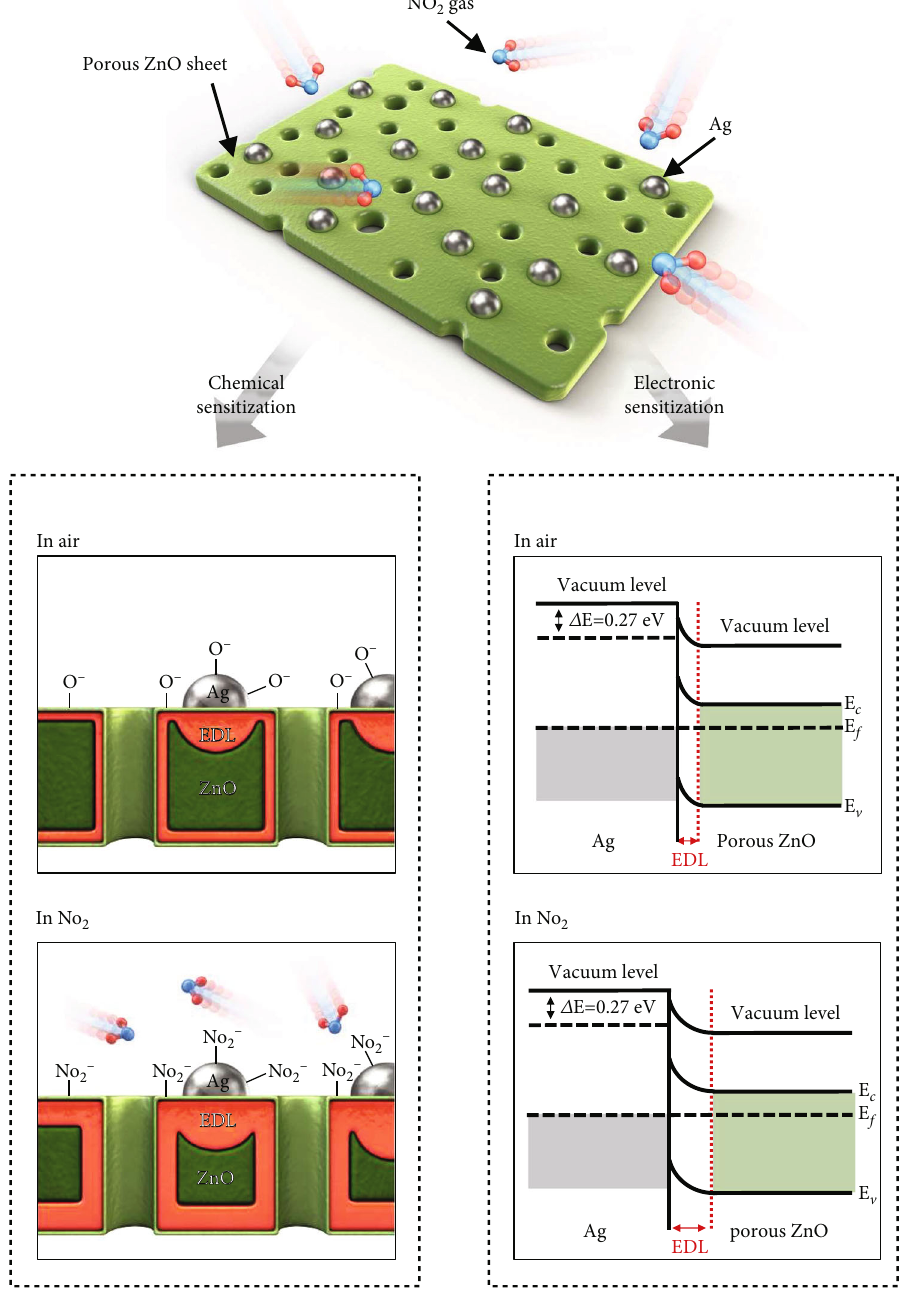
Figure 10: Schematic of the NO